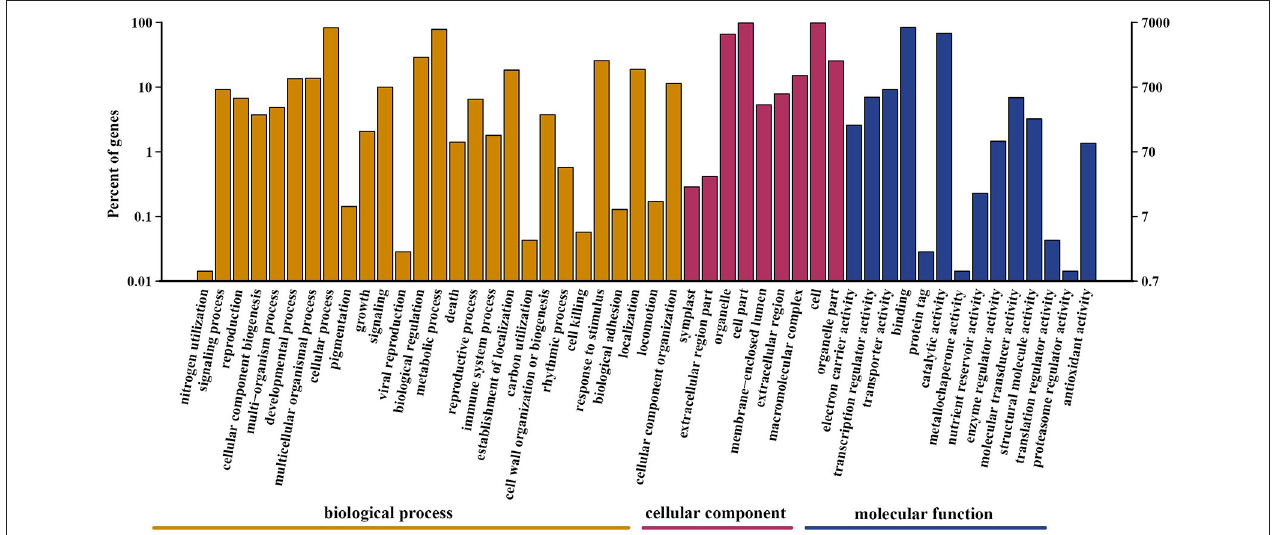
FIGURE 3 | Gene Ontology classification of unigenes. Unigenes were assigned to three categories: cellular component, molecular function, and biological process.